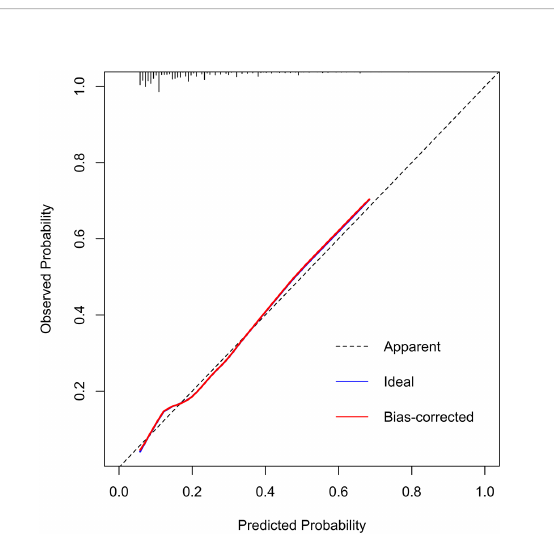
FIGURE 3 AUROC in training set.